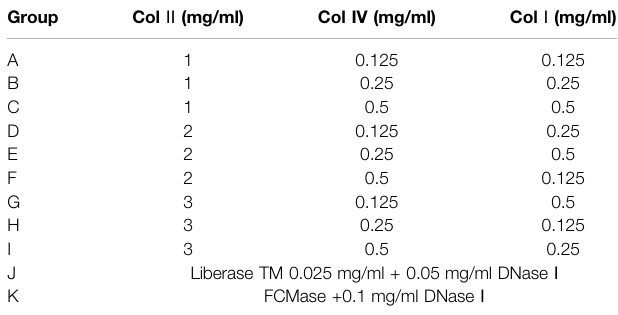
TABLE 1 | Orthogonal design of different digestive enzyme combinations. Group Col Ⅱ (mg/ml) Col IV